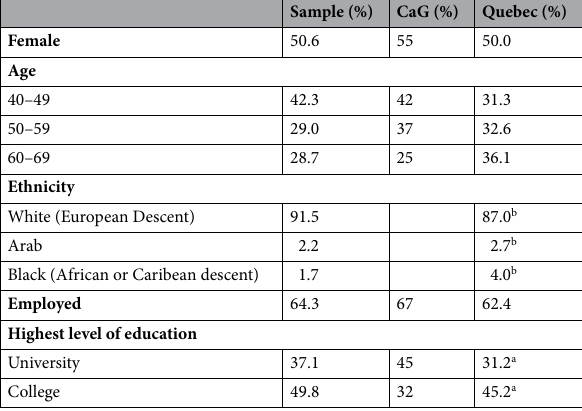
Table 1. Baseline characteristics. a Data for age range of 35–64 in the Quebec population (Banque de données des statistiques officielles sur le Québec 2015). b Data for overall province of Quebec (Statistics Canada